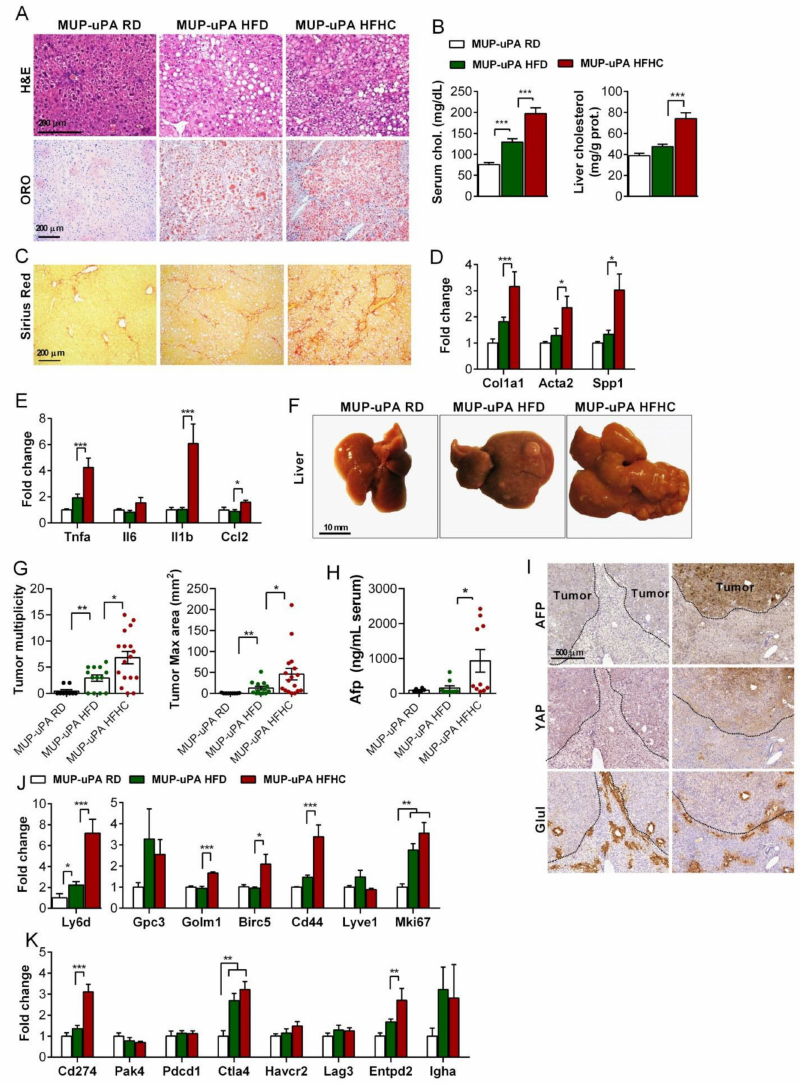
Figure 5. Cholesterol supplementation enhances NASH-associated liver tumorigenesis in MUP-uPA mice. ( A ) Representa- tive histological staining for H&E and neutral lipid (Oil Red O) of the liver sections from MUP-uPA transgenic animals fed a regular diet (RD), high-fat diet (HFD), and high-fat diet high-cholesterol (HFHC). ( B ) Serum total cholesterol concentrations and total cholesterol composition in liver tissue homogenates. ( C ) Histological staining for collagen fibers (Sirius red) of liver sections. ( D ) Transcript qPCR quantification of the fibrogenesis genes ( Col1a1 , Acta2 , and Spp1 ). N = 6 per group. ( E ) Expression levels of several inflammation-related genes ( Tnf α , Il1 β , Il6 , and Ccl2 ). N = 6 per group. ( F ) Representative macroscopic pictures of the whole liver of MUP-uPA transgenic mice in the different diets. (RD, n = 9; HFD n = 12; HFHC n = 17). ( G ) Macroscopic tumor quantification, number, and maximum size (RD, n = 9; HFC, n = 12; HFHC, n =